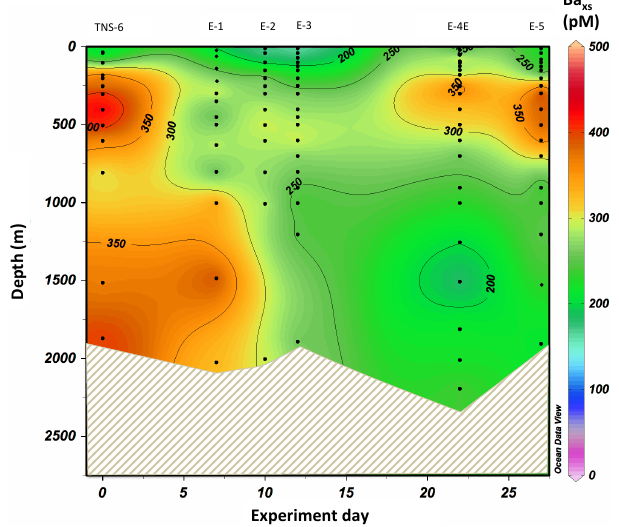
Figure 8. Temporal evolution of particulate biogenic Ba (Ba xs ; pM) in the upper 2000m water column in the polar front meander. Graph constructed using Ocean Data View (Schlitzer, 2002; Ocean Data View; http://www.awi-bremerhaven.de/GEO/ODV).